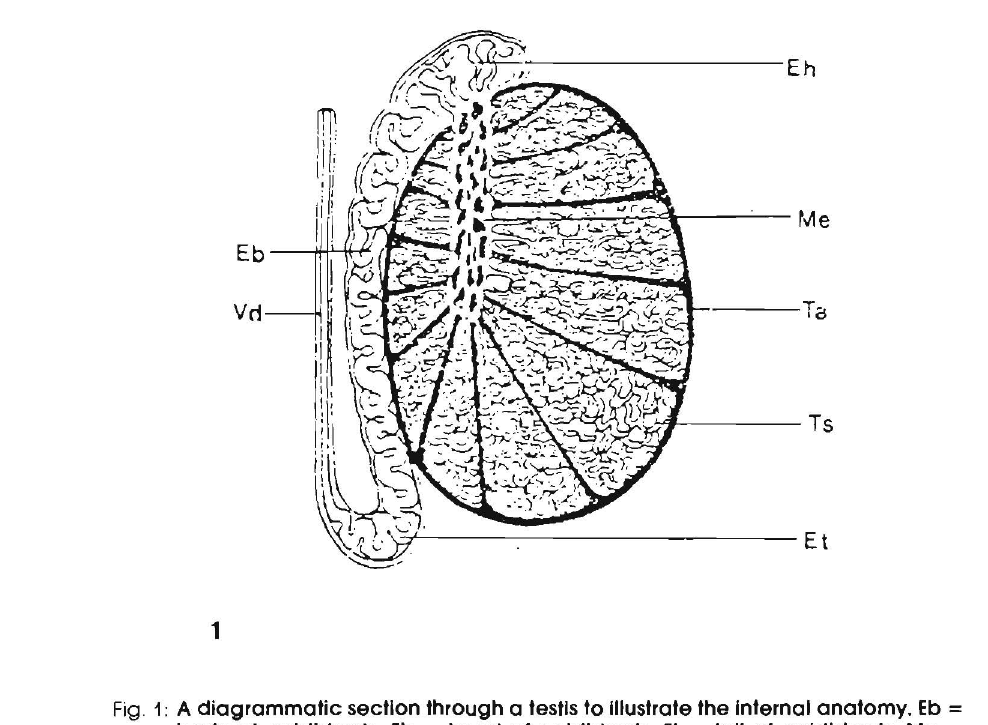
Fig. 1: A diagrammatic section through a testis to Illustrate the Internal anatomy. Eb = body of epidldymls;Eh = head of epididymis; Et = tail of epididymis; Me = mediastinum testis; Ta = tunica albuginea; Ts = tubuli seminlferl contorti with the tubuli seminlferi recti as the connecting pieces between the former and the mediastinum testis; Vd'=\ductus deferens. Note that the mediastinum testis is situated eccentrically